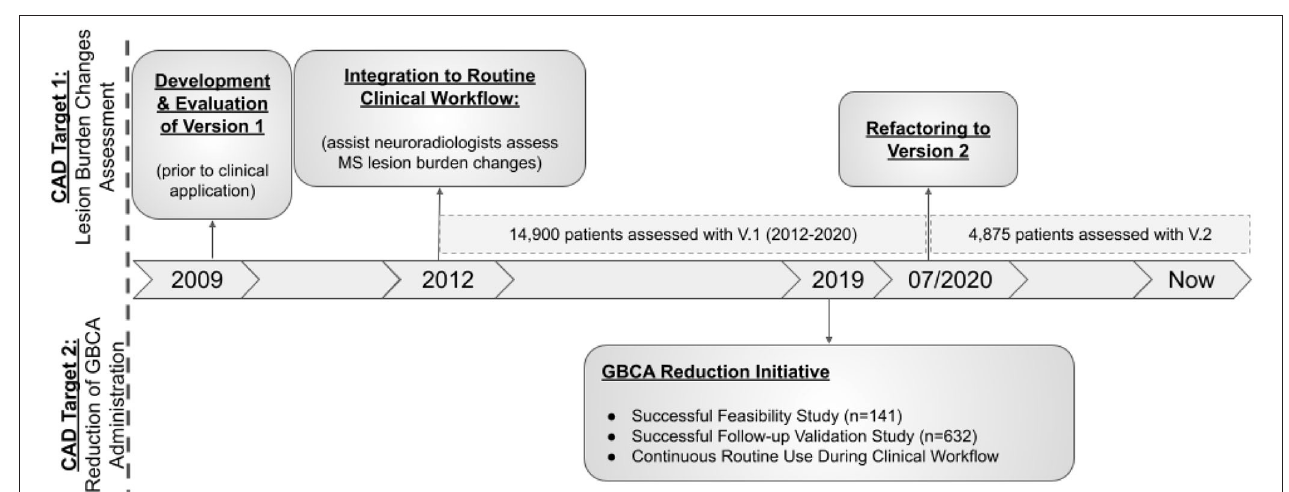
FIGURE 3 | Visual representation of the CAD’s lifecycle